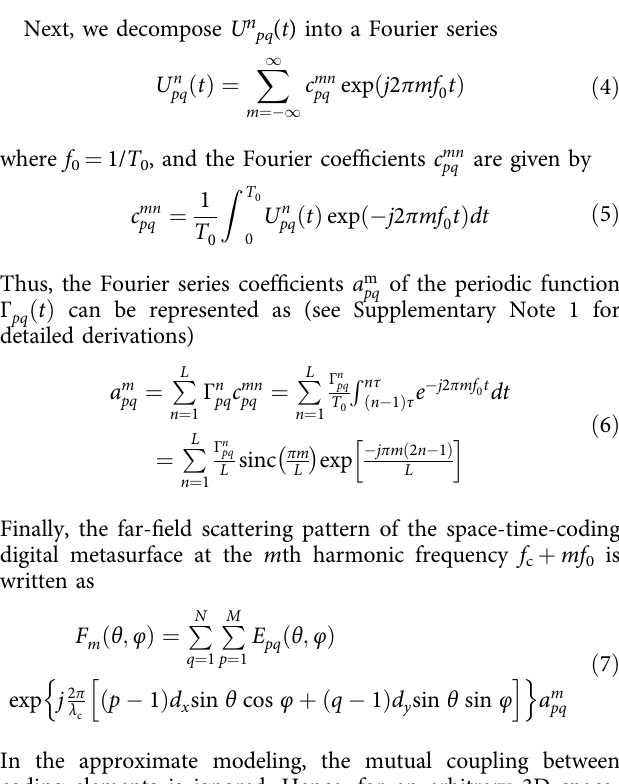
Fig. 1 Conceptual illustration of a space-time-coding digital metasurface. The re fl ection coef fi cient of the metasurface elements is dynamically controlled with discrete phase or amplitude states by applying control voltages to PIN diodes. In the illustrated example, the re fl ection phase of each coding element is periodically switched according to the digital “ 0/1 ” space-time-coding matrix, which can result in an equivalent multi-bit space-coding, such as “ 0 ′ ” , “ 1 ′ ” , “ 2 ′ ” and “ 3 ′ ” (equivalent 2-bit case). This coding strategy enables precise control of EM waves in both space and frequency